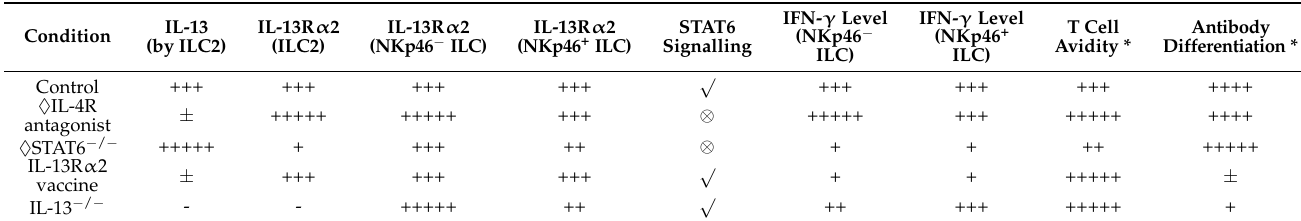
Table 1. Summary of ILC-derived cytokine and IL-13R α 2 expression on ILC 24 h post intranasal rFPV vaccination under different IL-4/IL-13 signaling conditions and resulting adaptive immune outcomes